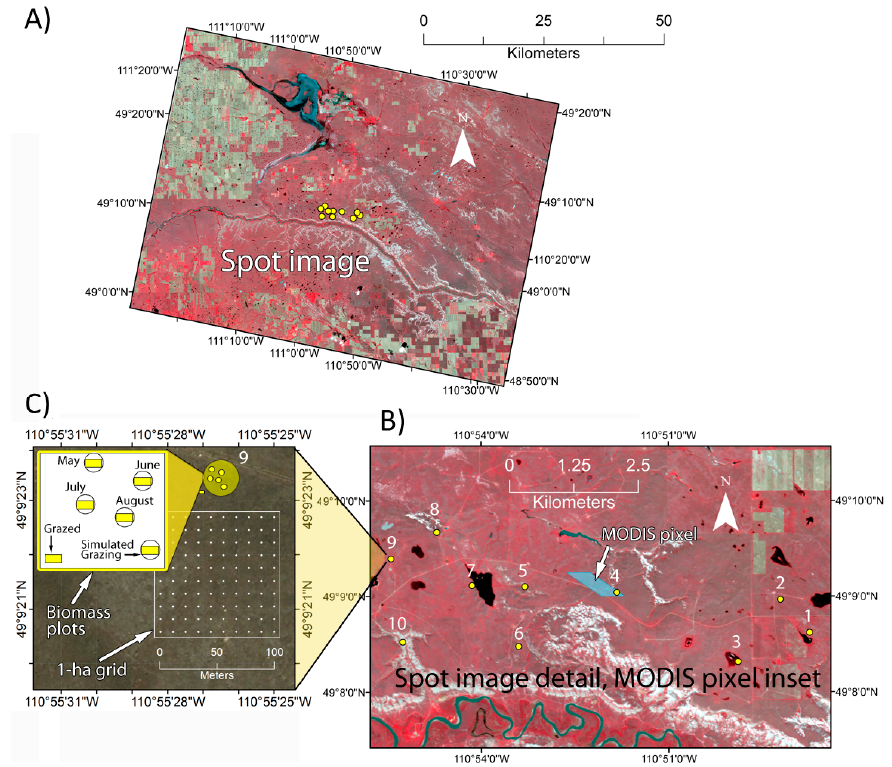
Figure 2. Sample SPOT image ( A ), showing field sampling sites (yellow dots) for the Pinhorn grazing reserve in 2009. ( B ) A detailed image of these sites, along with the single MODIS pixel (parallelogram) best corresponding to the centermost field sampling site. Each sampling site contained several 1-m diameter optical sampling plots (circles) ( C ) coincident with biomass harvestings sites (rectangles) ( C ) that were used for NDVI calibration against biomass. Each sampling site also included a 1-hectare (100 m × 100 m) sampling grid ( C ) that was used for comparison of ground NDVI to satellite NDVI measurements. See Sections 2.2–2.4 for field sampling protocols.